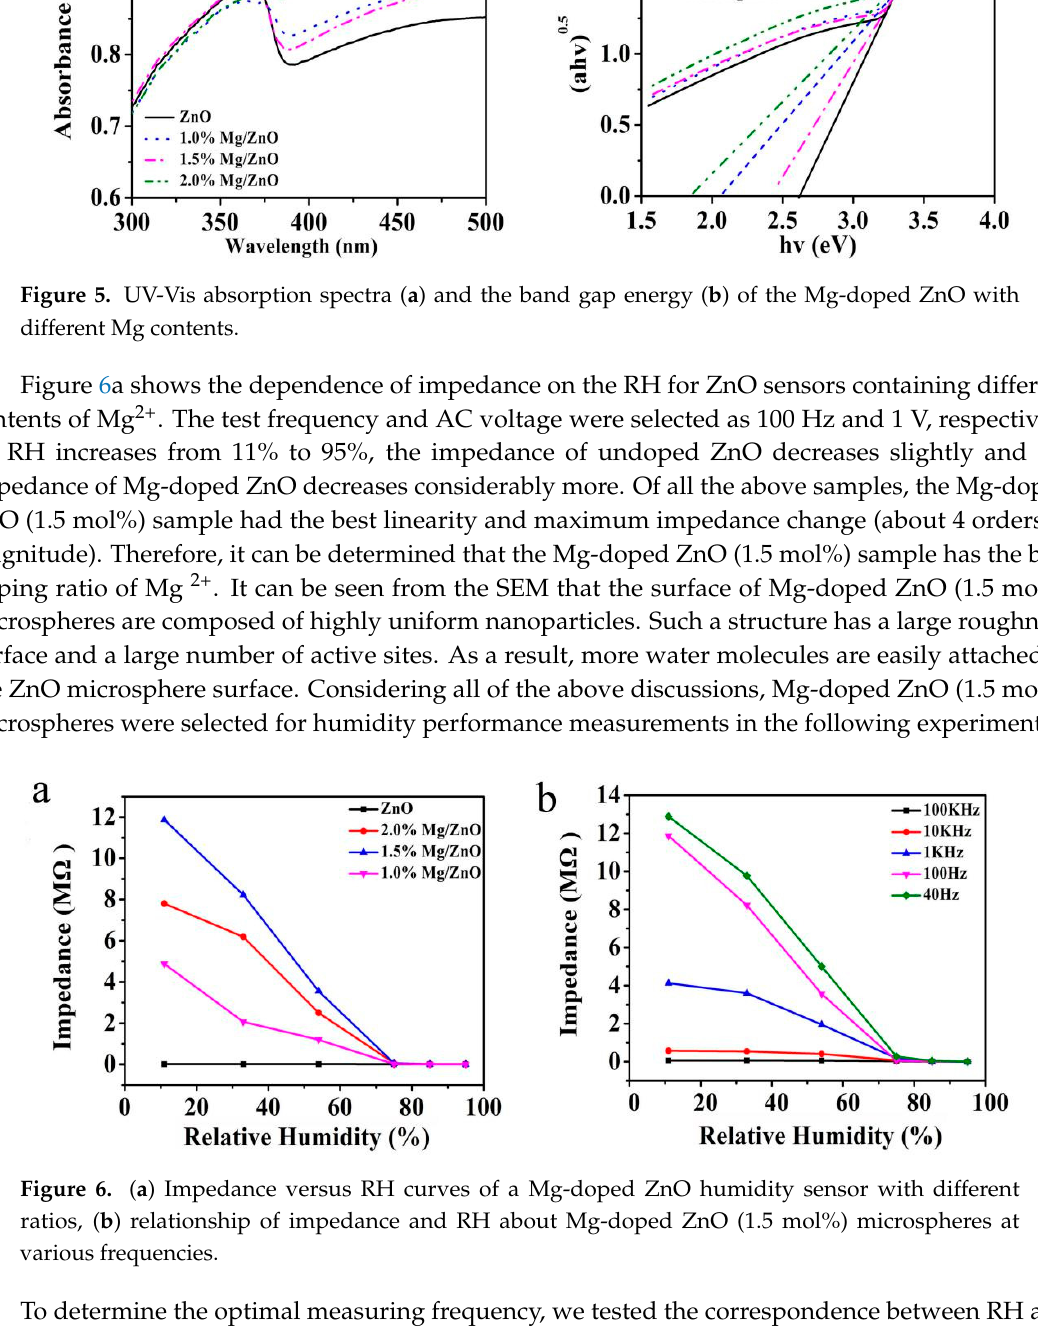
Figure 5. UV-Vis absorption spectra ( a ) and the band gap energy ( b ) of the Mg-doped ZnO with different Mg contents.